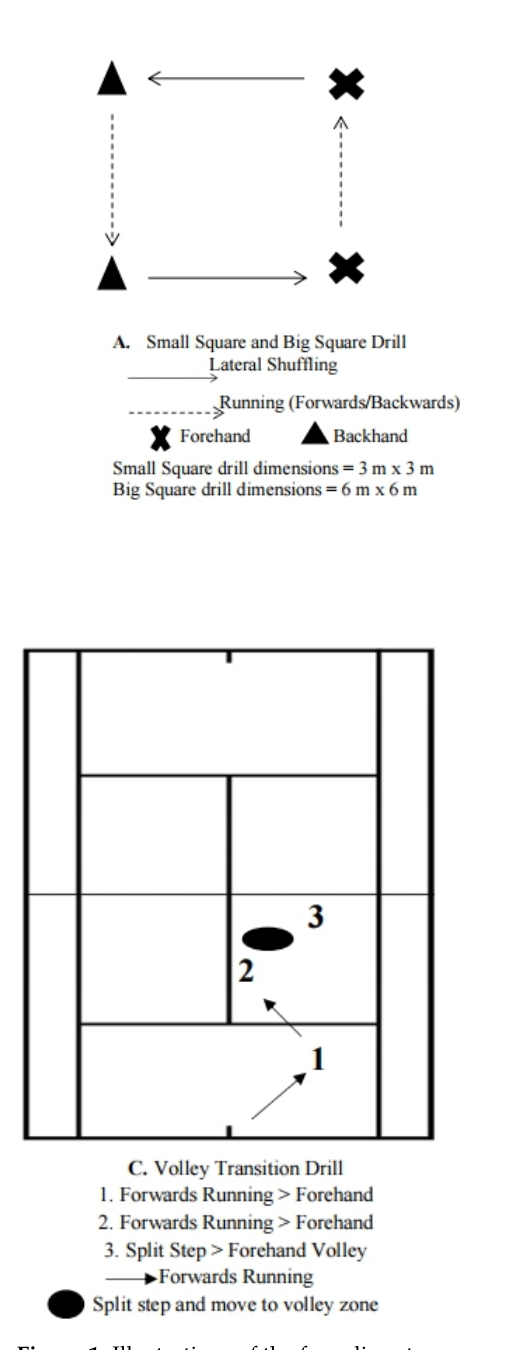
Figure 1. Illustrations of the four discrete movement drills used in the ‘simulated